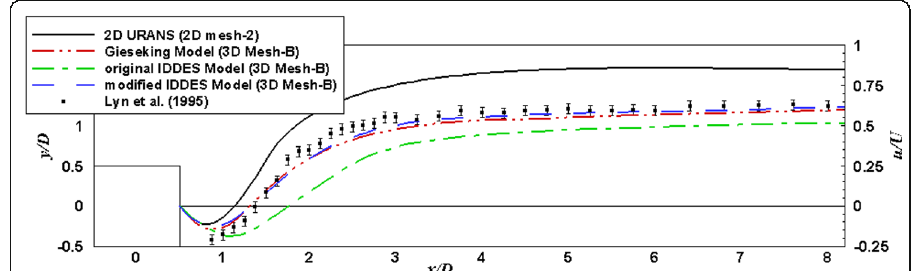
Fig. 4 Mean streamwise velocity profile along the wake centerline predicted by simulations with URANS model and 3D